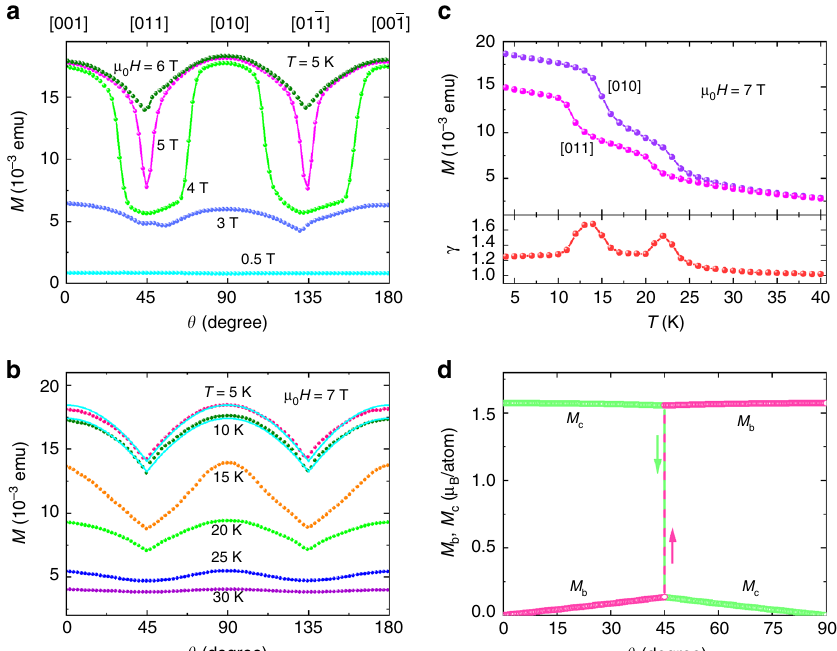
Fig. 3 Anisotropic magnetization induced by orbital fl ops. a Angle dependence of the measured magnetization of Sample C at T = 5 K and at various magnetic fi elds. b Angle dependence of the measured magnetization at μ 0 H = 7 T and at various temperatures. c Temperature dependence of the measured magnetization at μ 0 H = 7T and at two magnetic fi eld orientations. γ is the ratio of the magnetizations at [010] and [011]. The cyan curves in ( b ) represent theoretical results from the phenomenological model. d Angle dependence of the magnetizations along the [010] ( b -axis) and [001] ( c -axis) derived from a phenomenological model (see text) for the ferromagnetic phase, revealing an orbital- fl op at θ = 45°. μ B is the Bohr